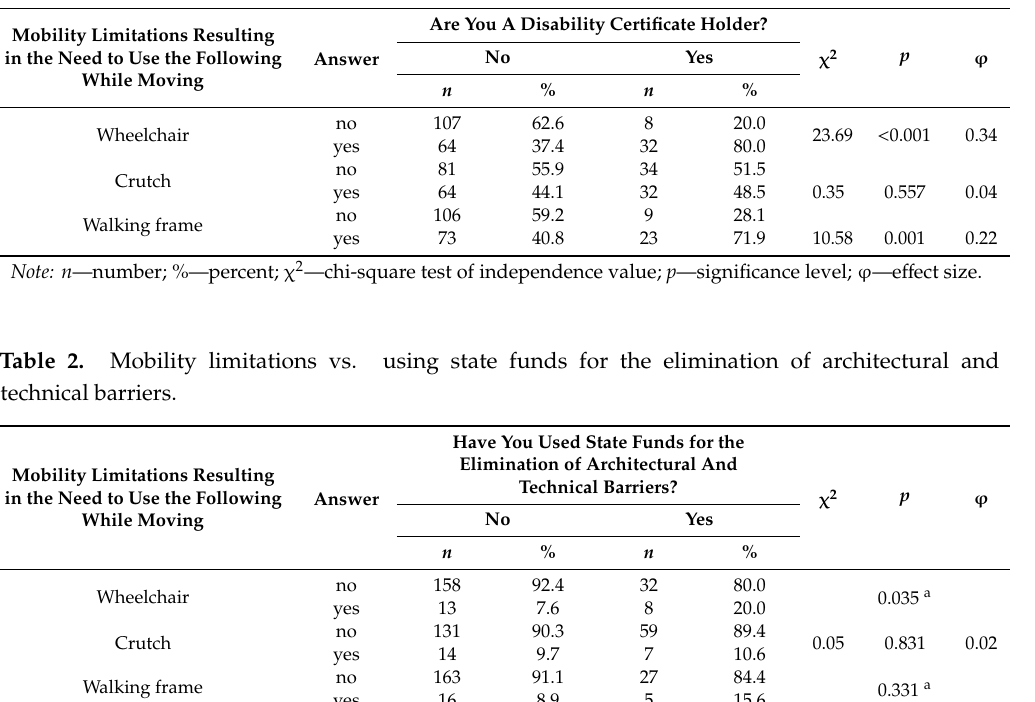
Table 1. Mobility limitations vs. the disability certificates held.